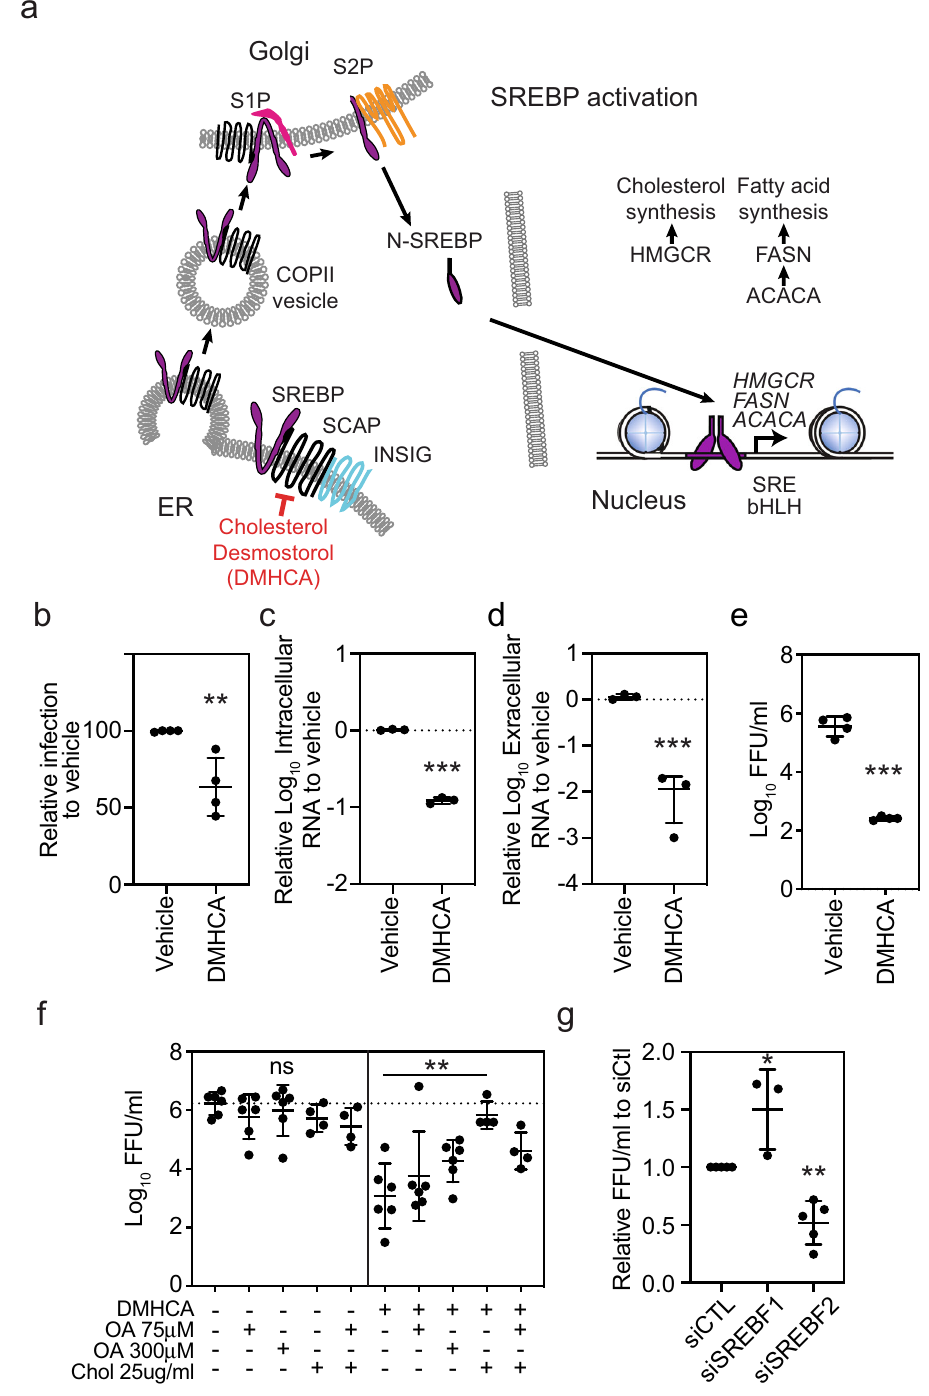
Fig. 5 | Treatment of moDCs with the SREBP2 inhibitor DMHCA suppresses ZIKV infection. a Simpli fi ed model of the SREBP activation pathway. b moDCs were treated with vehicle (ethanol) or DMHCA (10 μ M) for 4h, infected with ZIKV PRVABC49(MOI1)for24h,andZIKV-infectedcellswerequanti fi edby4G2staining and fl ow cytometry. c – e moDCs were infected with ZIKV PRVABC49 (MOI 1) and treated with DMHCA (10 μ M) at 2.5h post infection (pi). At 24h pi, c intracellular and d extracellular ZIKV RNA were quanti fi ed by qRT-PCR and e infectious virions were quantitated by focus-forming assay (FFA). Data are presented as the mean± SD. n =4 ( b , e ) or n =3 ( c , d ) biologically independent experiments. f moDCs were infectedwithZIKVPRVABC59(MOI1)for1h,washed,andtreatedwithvehicle(left) or DMHCA 10 μ M (right) in the presenceor absenceofoleic acid – BSA (OA)and/or